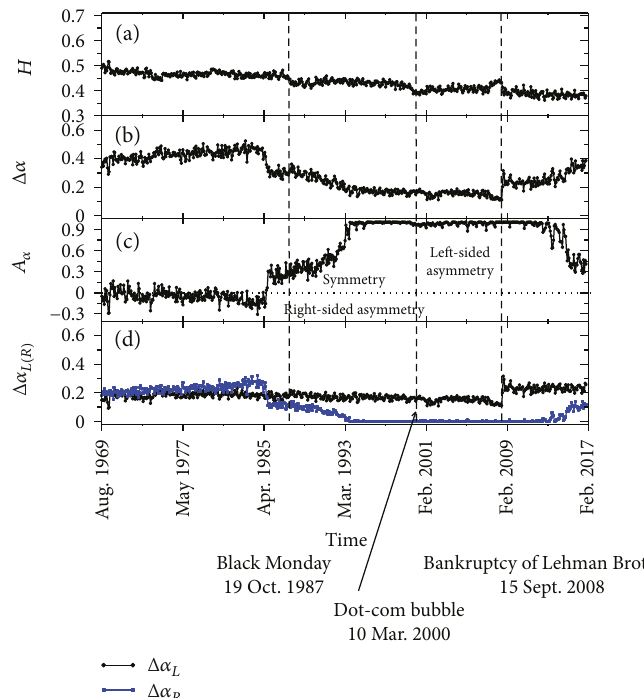
Δα α , and the widths L R for the time sequence